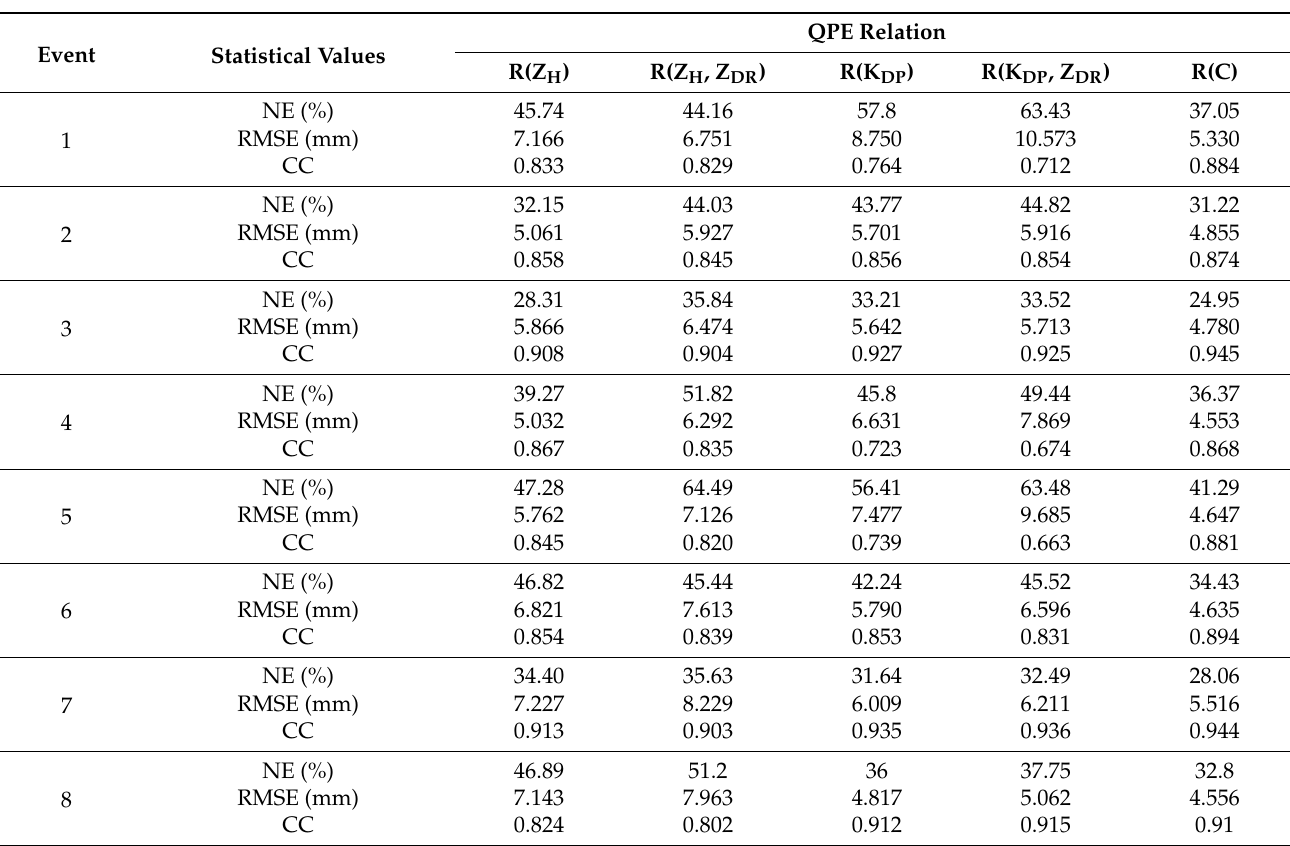
Table 2. Evaluated statistical values for each rainfall relation of the eight monsoon rainfall events.